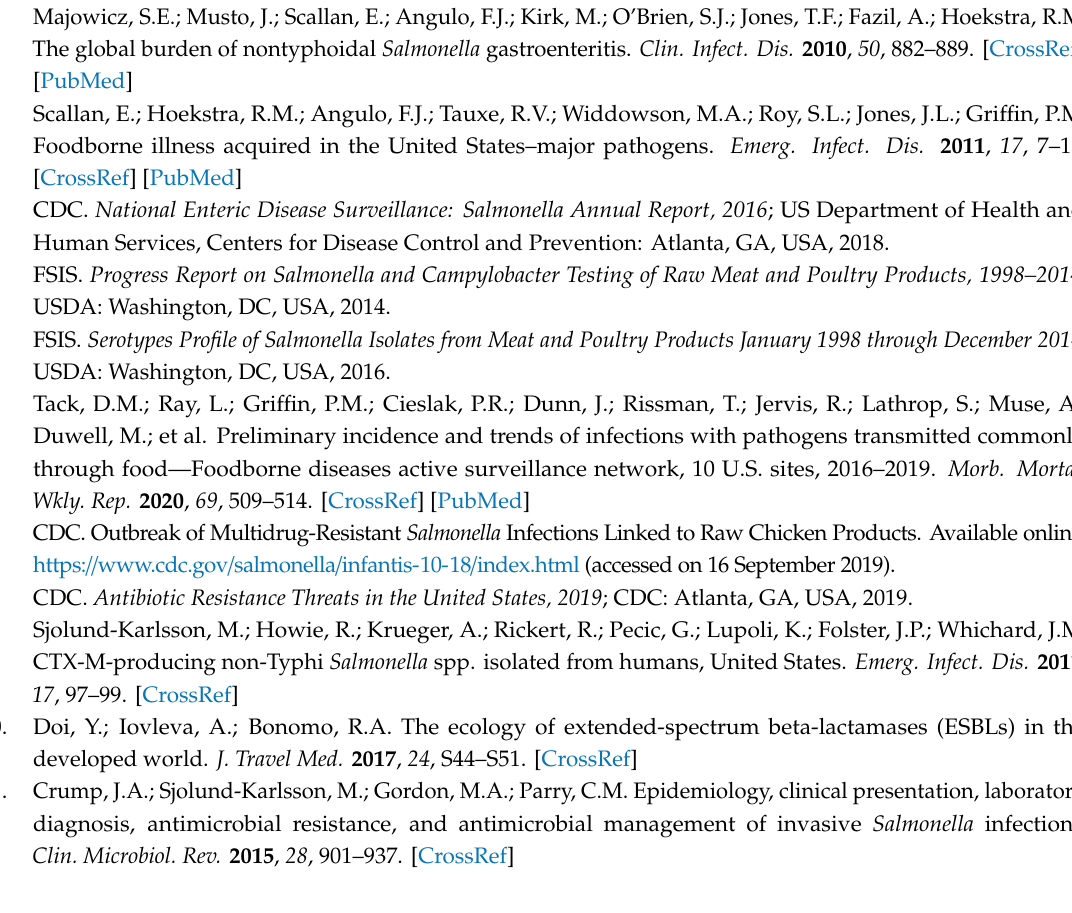
Table S1: Target sequences used to determine pESI presence in isolates collected for NARMS, Table S2: Details of isolates included in the pan-plasmid genome analysis, Table S3: Genes present in greater than 99% of isolates with locations relative to the genes in CP016407.1. Hypothetical proteins are not listed. tnp indicates unnamed transposase gene. Gene names were identified using BLAST, Table S4: Genes present in greater than 95% and less than 99% of isolates with locations relative the genes in CP016407.1. Hypothetical proteins are not listed. tnp indicates unnamed transposase gene. Gene names were identified using BLAST, Table S5: Genes present in greater than 90% and less than 95% of isolates with locations relative the genes in CP016407.1. Hypothetical proteins are not listed. tnp indicates unnamed transposase gene. Antibiotic resistance genes present in less than 90% of isolates are also listed with the percentage of isolates that contain them in brackets next to the gene name. Gene names were identified using